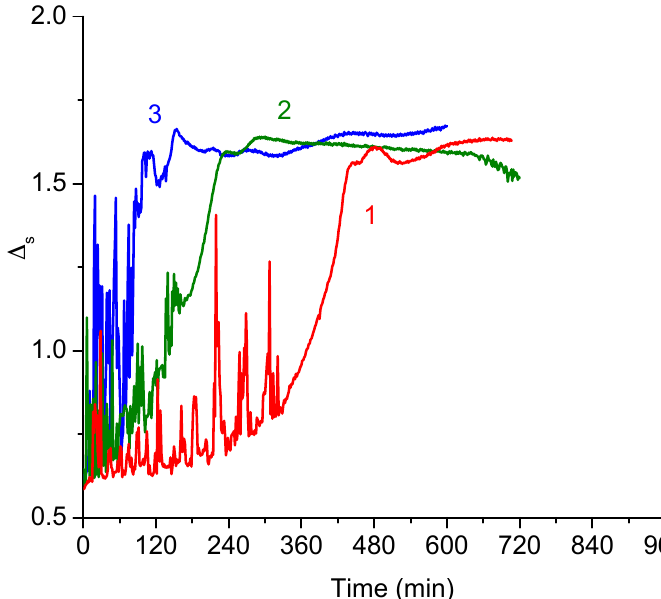
Figure 6. Kinetic dependencies of the ellipsometric angle ∆ s of the PDAHMAC layer after DNA injection into subphase. The total DNA concentrations are 7 (1), 14 (2) and 28 (3) µ M. The initial surface pressure of the PDAHMAC layer is 7 mN/m.